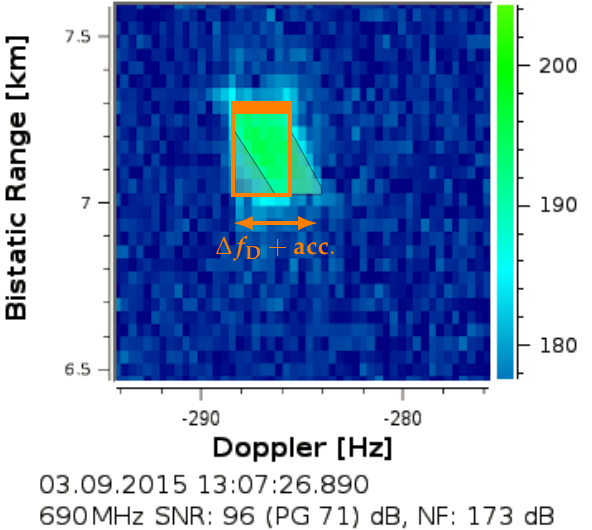
Figure 15. Limit of a fixed time-scale analysis with the example from Figure 6b of slight acceleration, the deviation from a rectangular extent would cause less returned energy and more noise